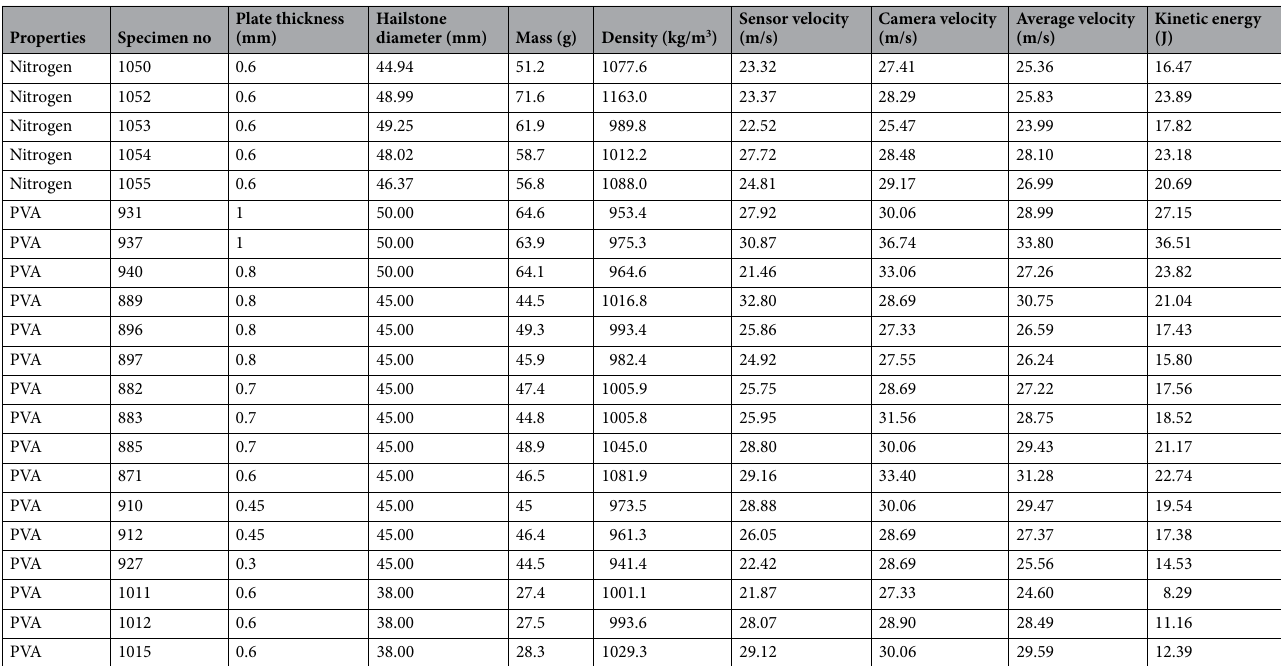
Table 2. Measured data properties of hailstones used in this study before impact